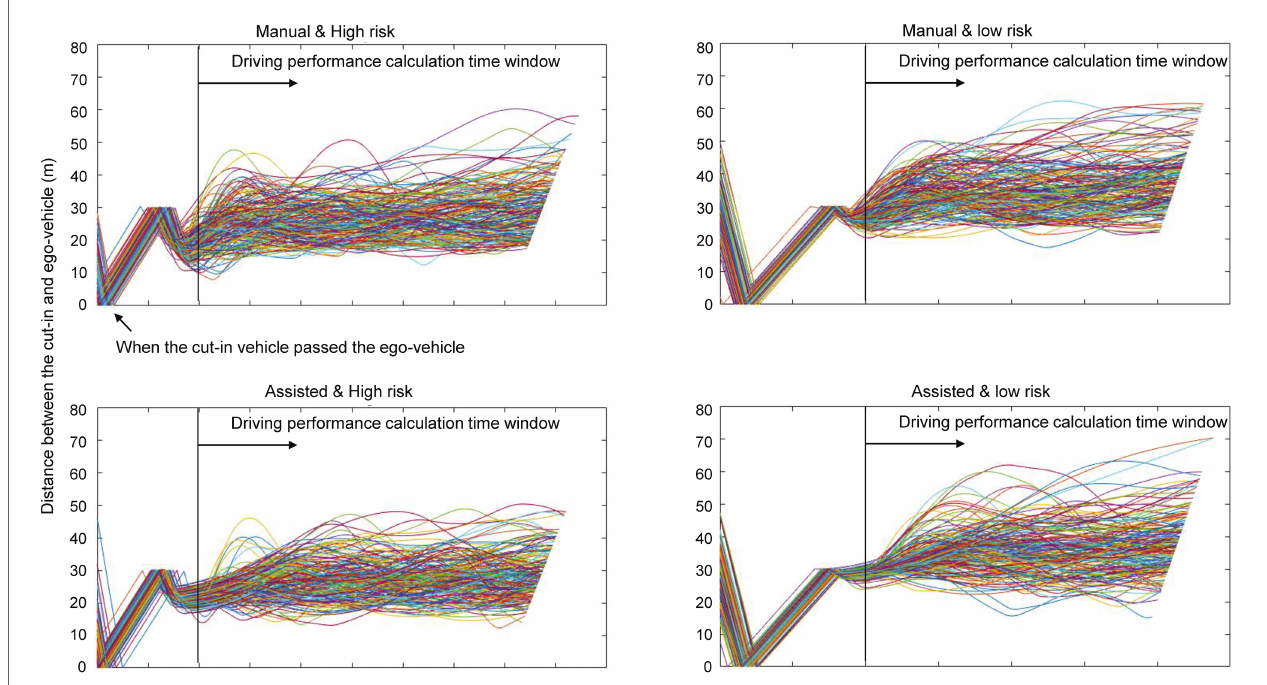
FIGURE 4 | Plots of inter-vehicular distance in the calculation time window of each condition.